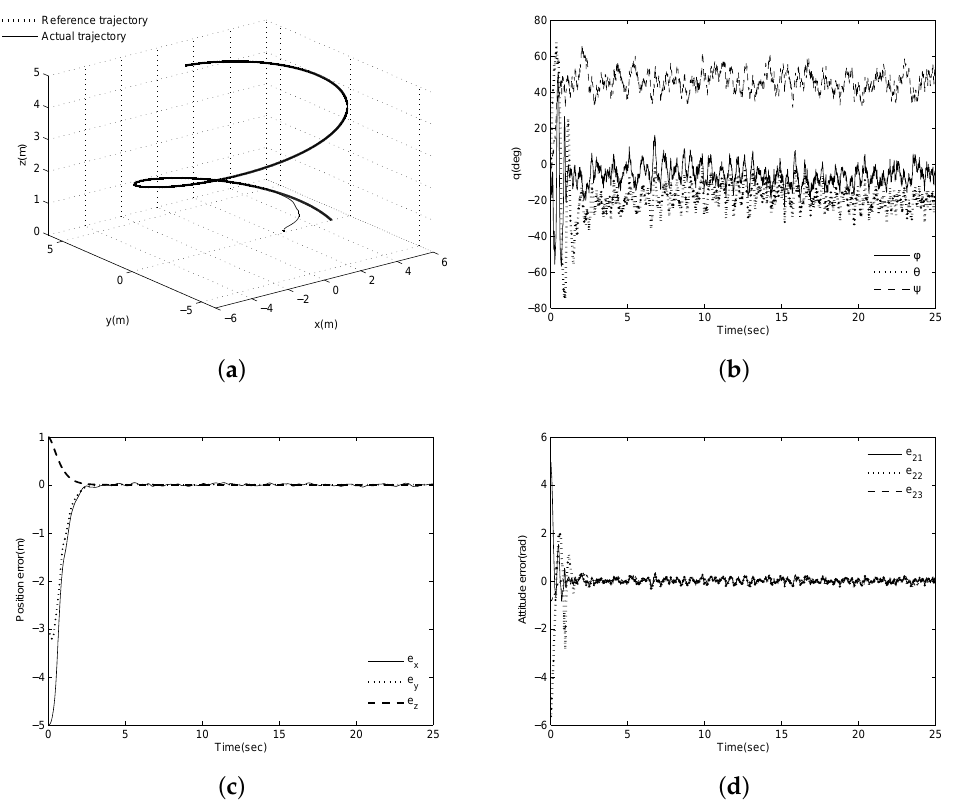
Figure 6. Tracking results in noise environment: ( a ) Three-dimensional trajectory; ( b ) Euler angles q ; ( c ) position tracking errors; ( d ) attitude tracking